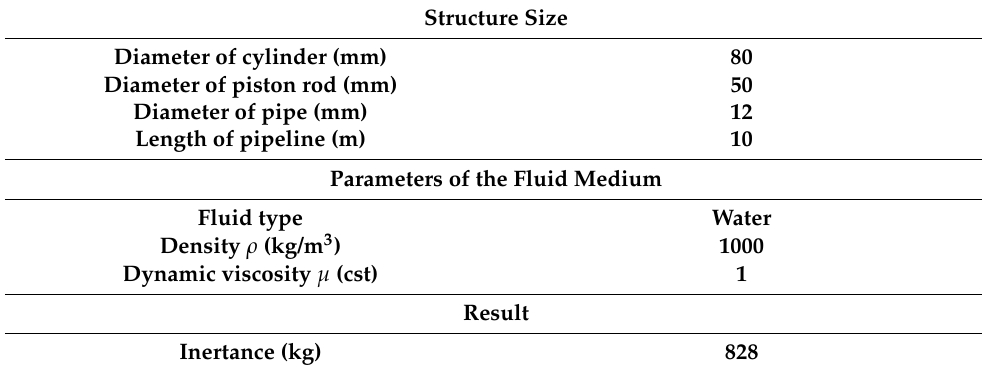
Table 3. Table of structure and fluid parameters of the dual cylinder fluid inerter.